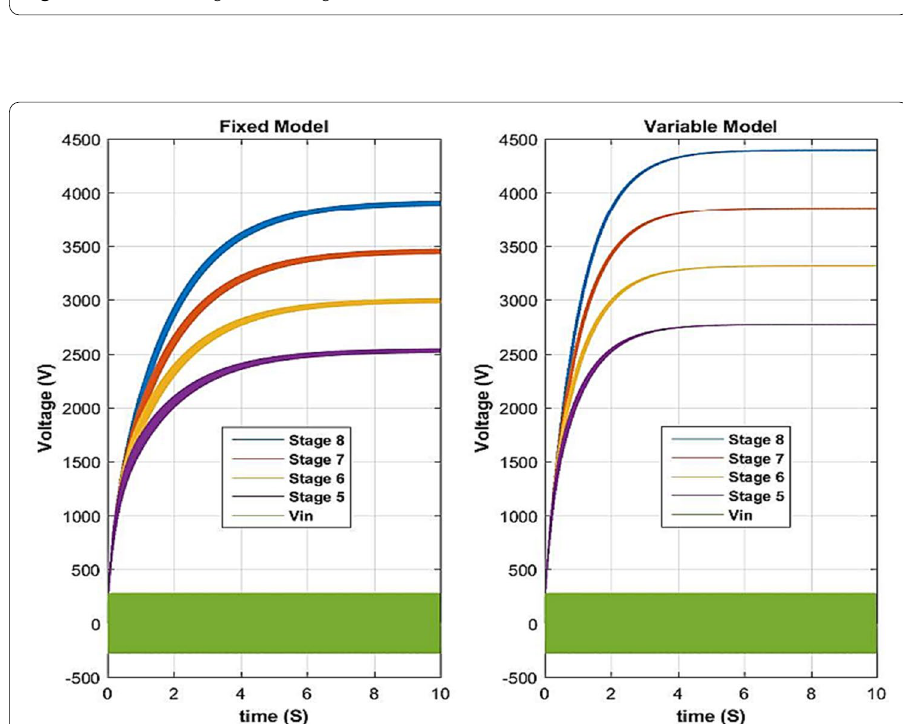
Fig. 7 Output voltage for the fifth stage through the eighth